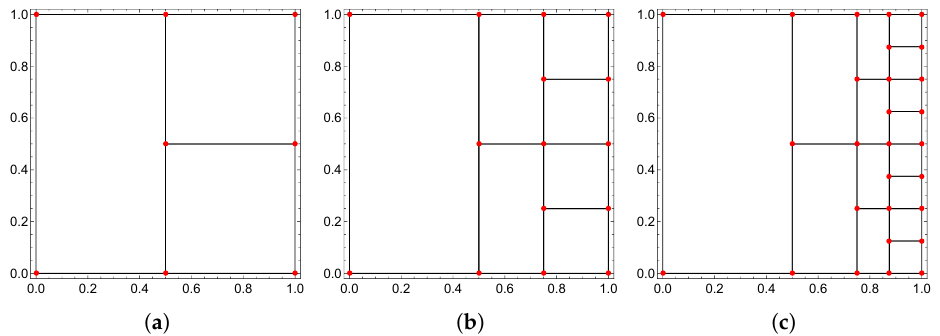
Figure 6. Sequence of refined meshes. Same replacement rule applied three times with a unit square as the initial configuration. The underlying finite element discretisation is continuous, despite the apparent hanging nodes. ( a ) Rule applied once. ( b ) Rule applied twice. ( c ) After three applications of the